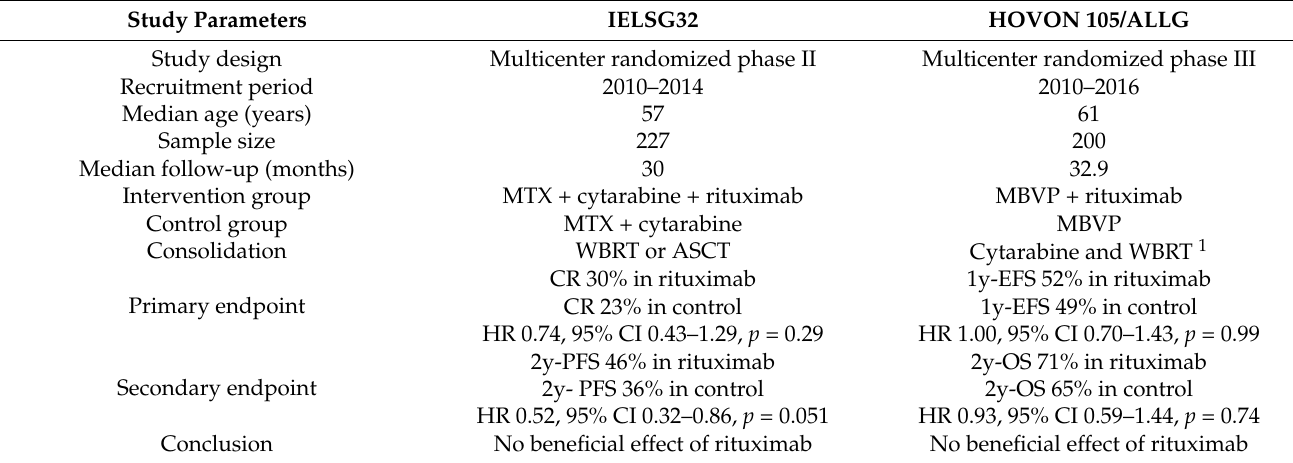
Figure 1. Flow diagram of systematic review according to Preferred Reporting Items for Systematic Reviews and Meta-Analyses (PRISMA) guidelines. Table 1. Overview of the randomized controlled trials on the effect of rituximab in primary central nervous system lymphoma (PCNSL).